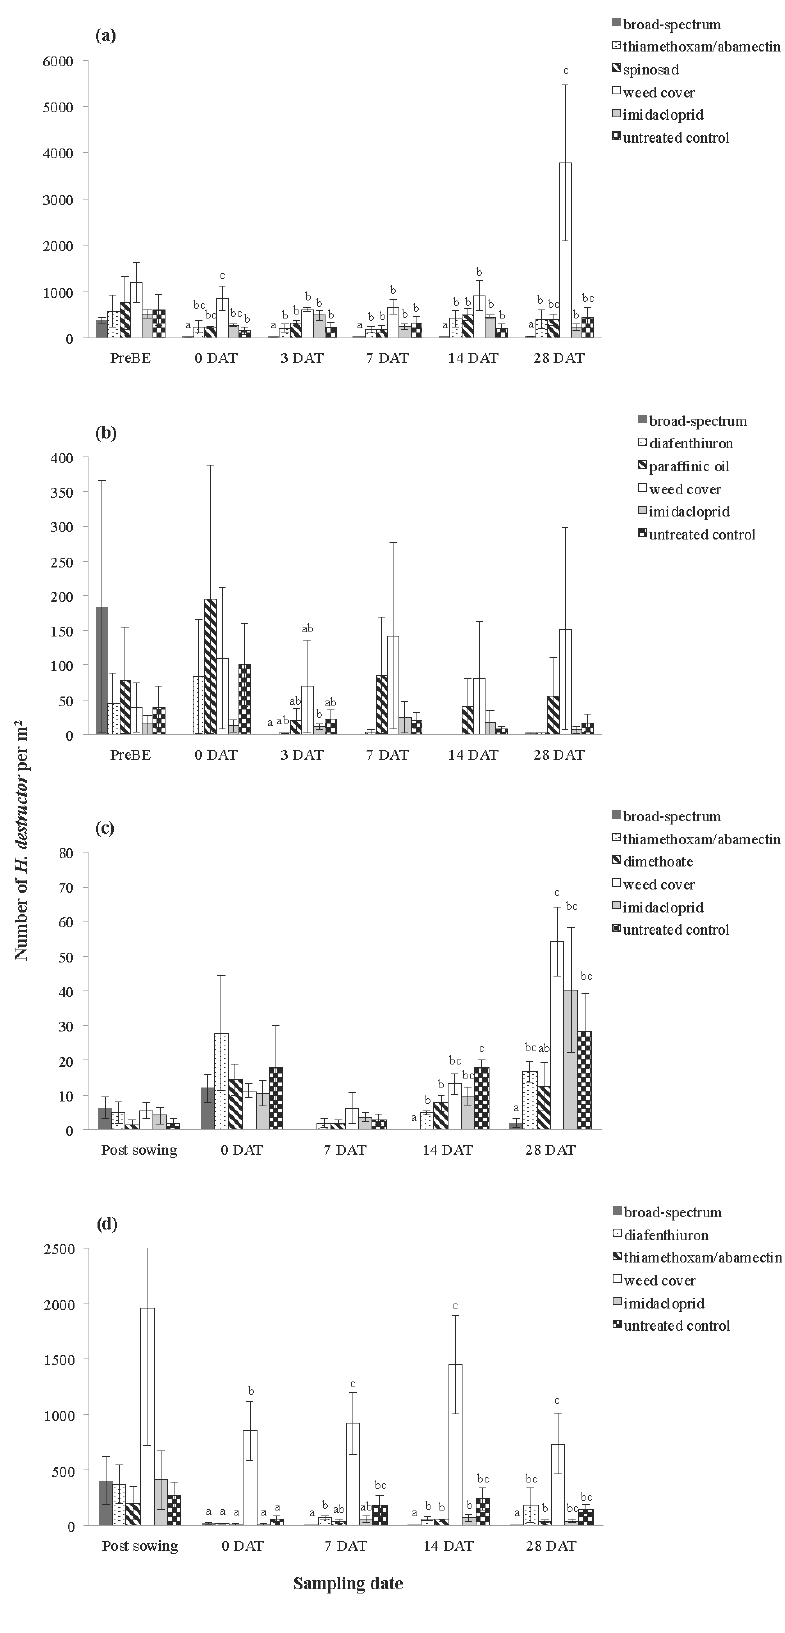
Figure 2. Average number of H. destructor collected using vacuum sampling at ( a ) Inverleigh 2009, ( b ) Rossbridge 2009, ( c ) Inverleigh 2010 and ( d ) Rossbridge 2010. Error bars represent standard errors of the mean. Different letters above bars indicate significantly different means at each sampling date (at the p < 0.05 level, Tukey’s- b post hoc